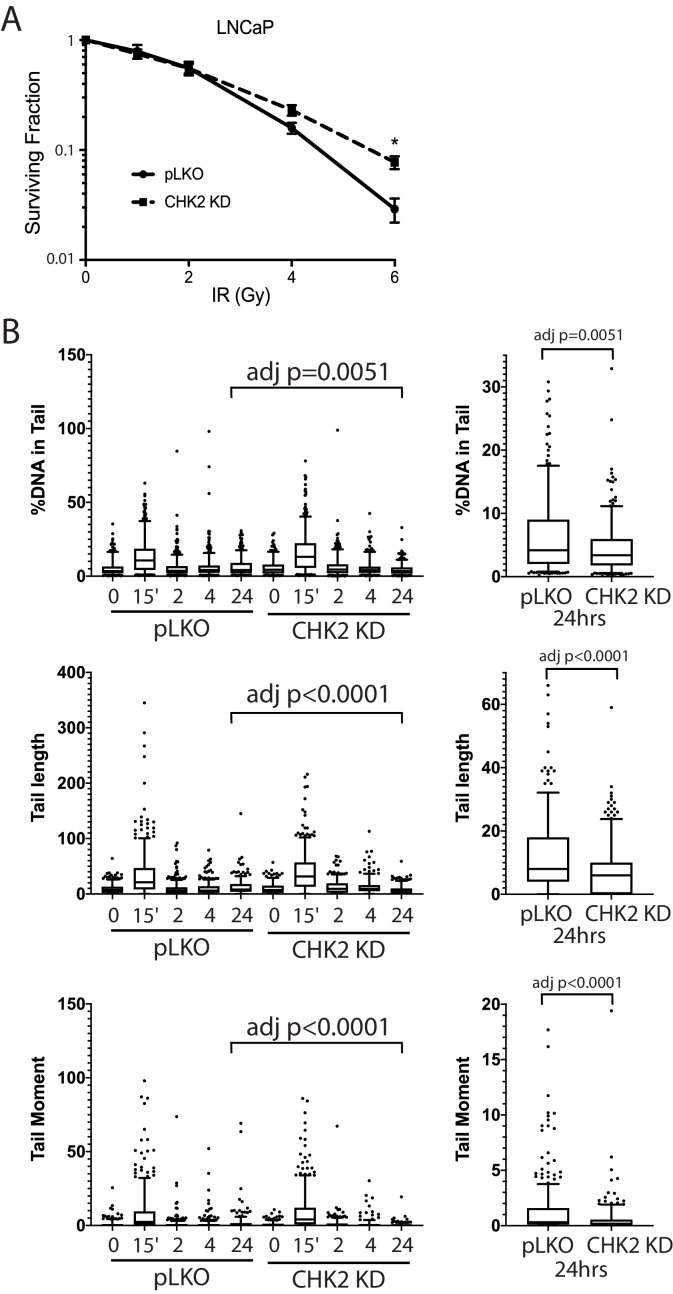
CHK2-depleted cells show increased survival and reduced DNA damage following radiation.(A) Knockdown of CHK2 desensitizes cells to IR. LNCaP cells were transduced with lentiviral particles expressing pLKO or CHK2 shRNAs for 48 hr, treated with 0-6Gy IR, and seeded at the appropriate cell number for colony survival assays. Results were normalized to untreated pLKO control and fitted to a standard linear quadratic model. Error bars, SEM. Statistical analysis was performed using the Student’s t-test, n = 4–8, p<0.01. (B) LNCaP cells were transduced with lentiviral particles expressing pLKO or CHK2 shRNAs for 48 hr, irradiated at the indicated doses at the specified times and processed for comet assays. Shown is the %DNA in the comet tail, comet tail length, and tail moment (% DNA x tail length), n = 3 (209–592 cells measured per condition), 5–95% confidence intervals. Right most plots are of pLKO and CHK2 KD at 24 hr to illustrate the statistical difference marked on the graphs. Statistical differences were tested for using Kruskal-Wallis test followed by Dunn’s multiple comparisons test.